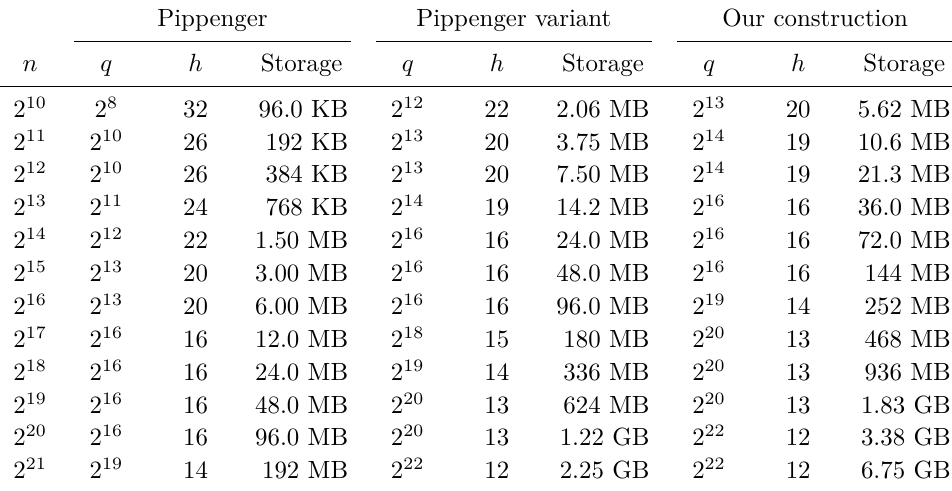
Table 2: Radix q , length h and precomputation size utilized to compute S n,r